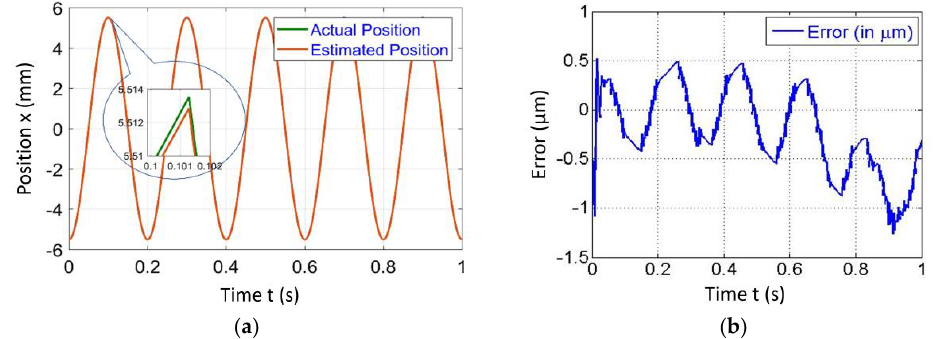
Figure 6. Simulated results of the position estimator algorithm at 5 Hz frequency for ( a ) Position comparison and ( b ) Error between actual and estimated position.